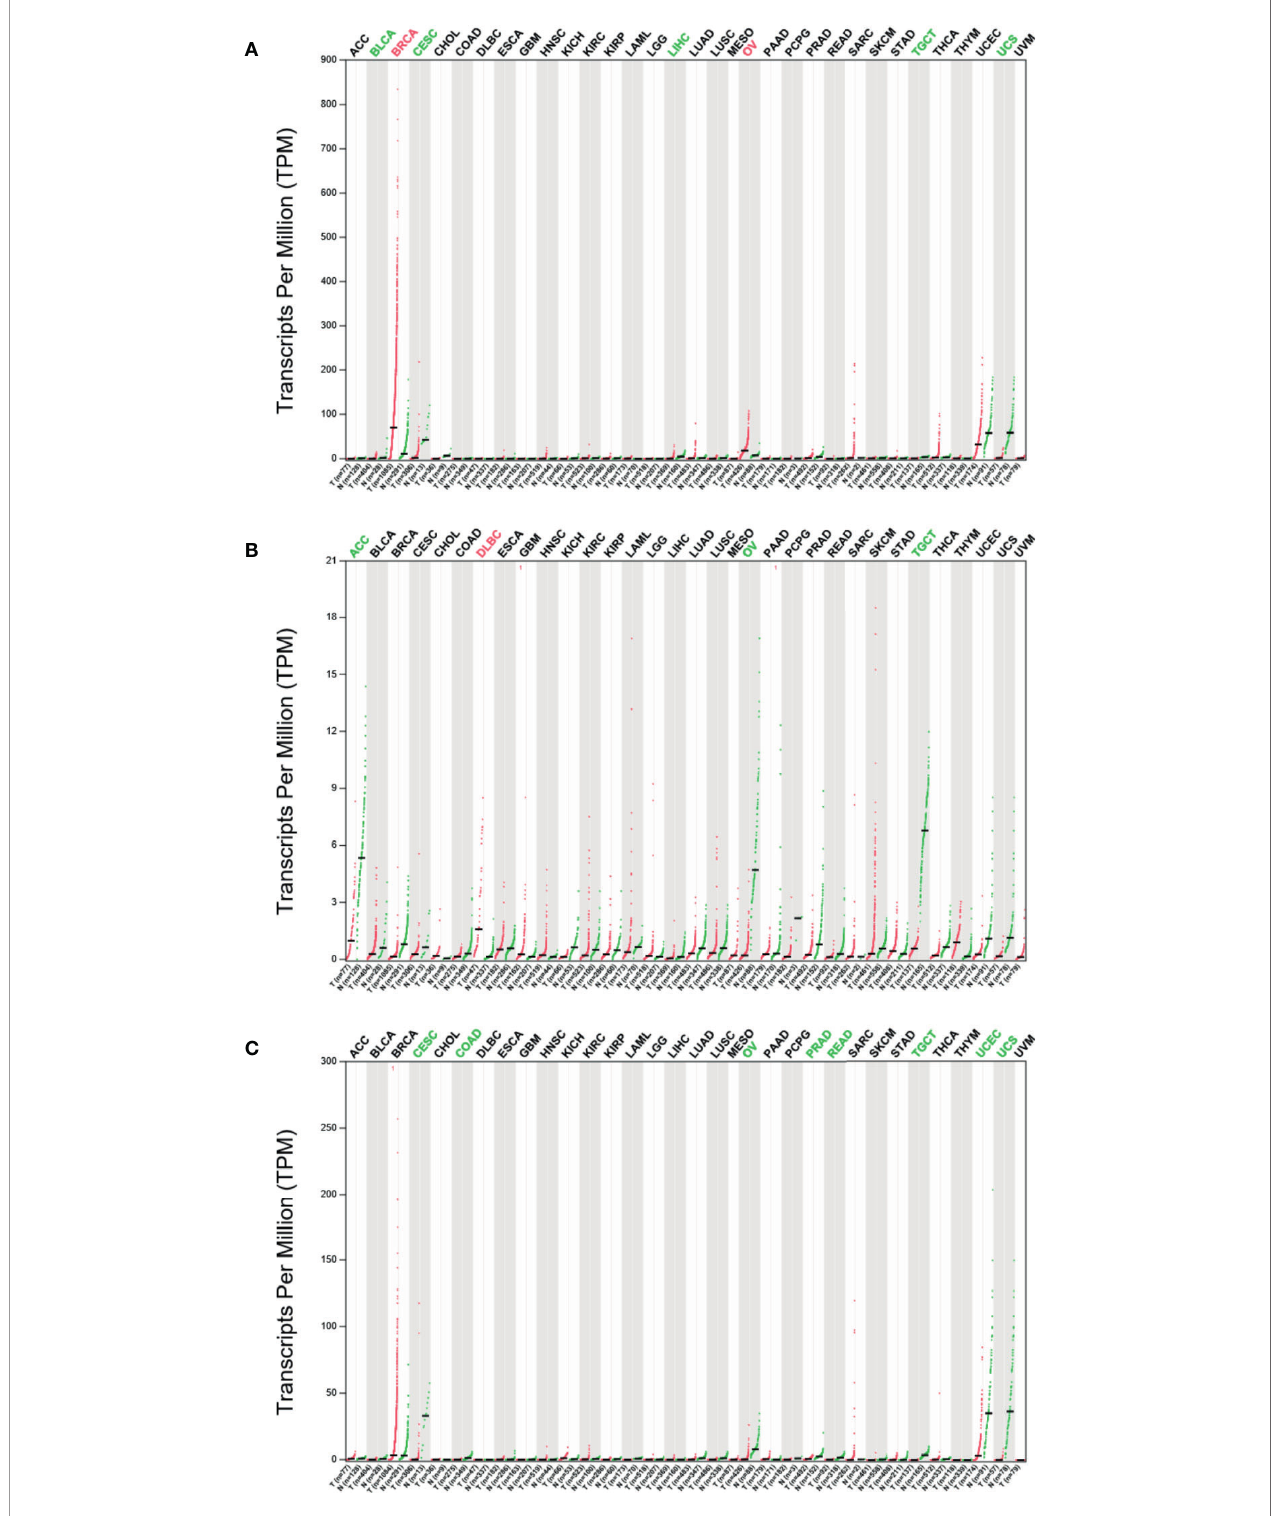
FIGURE 1 | Expression pro fi le of ESR1 , ESR2 , and PGR mRNAs across multiple cancer and matched normal samples. (A) Expression pro fi le of ESR1 mRNA across multiple cancer and matched normal samples. (B) Expression pro fi le of ESR2 mRNA across multiple cancer and matched normal samples. (C) Expression pro fi le of PGR mRNA across multiple cancer and matched normal